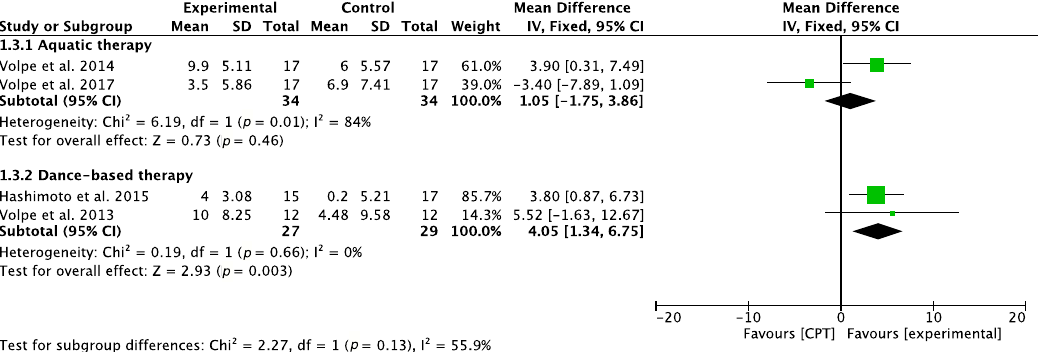
Figure 5. Forest plot for balance confidence measured by ABC. Green block indicates the weight assigned to the study and the horizontal line depicts the confidence interval. Black rhombus shows the overall result. The bold words highlight the total/subtotal values and the different modalities of therapies used in the interventions. 3.3.4. Fall-Related Self-Efficacy (FES) Concerning the fear of losing balance and suffering a fall, analyzed through the FES, the overall result of the meta-analysis was inconclusive, although Volpe et al. [30] reported significant results in favor of AT. The results of the meta-analysis are shown in Figure 6. Figure 6. Forest plot for fall-related self-efficacy measured by FES. Green block indicates the weight assigned to the study and the horizontal line depicts the confidence interval. Black rhombus shows the overall result. The bold words highlight the total/subtotal values and the different modalities of therapies used in the interventions.